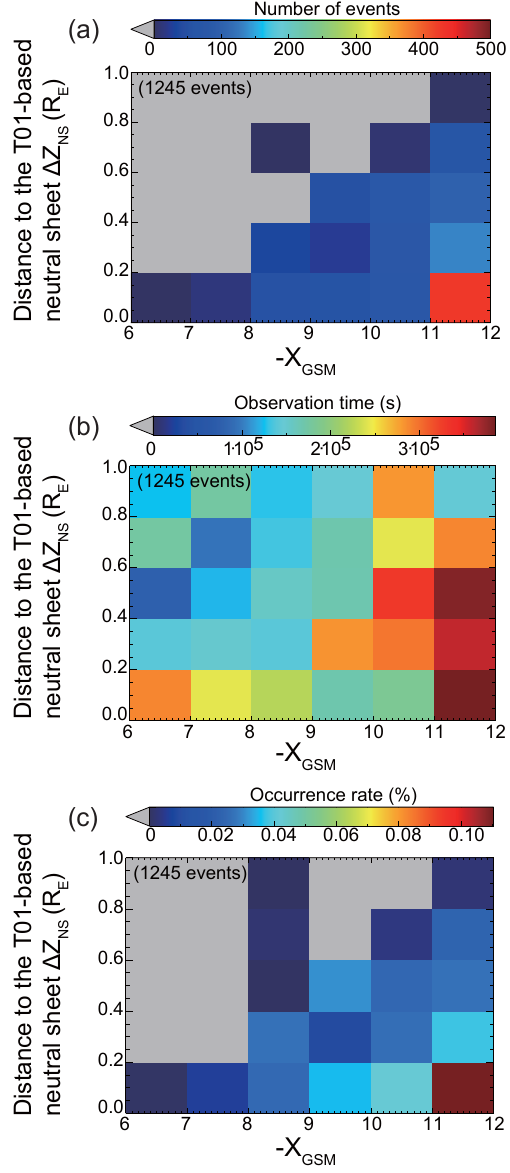
Figure 6. The spatial distribution of (a) the number of fluctuation events, (b) observation times when the satellite was in the given GSM- XY bin, and (c) the occurrence rates of the fluctuation events normalized by the observation times in the GSM- XY plane.